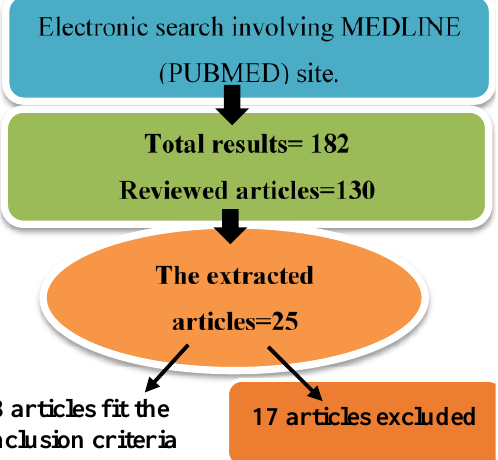
Diagram 1: The search